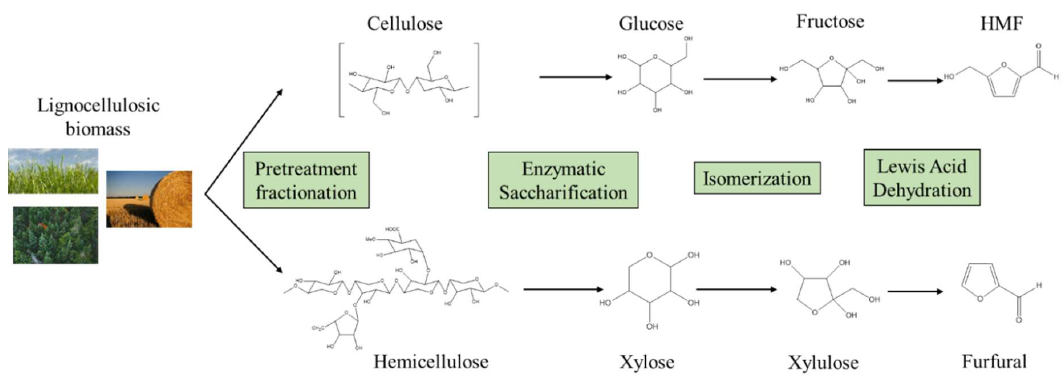
Figure 1. Overview of the process illustrating how furans can be produced from lignocellulosic biomass.